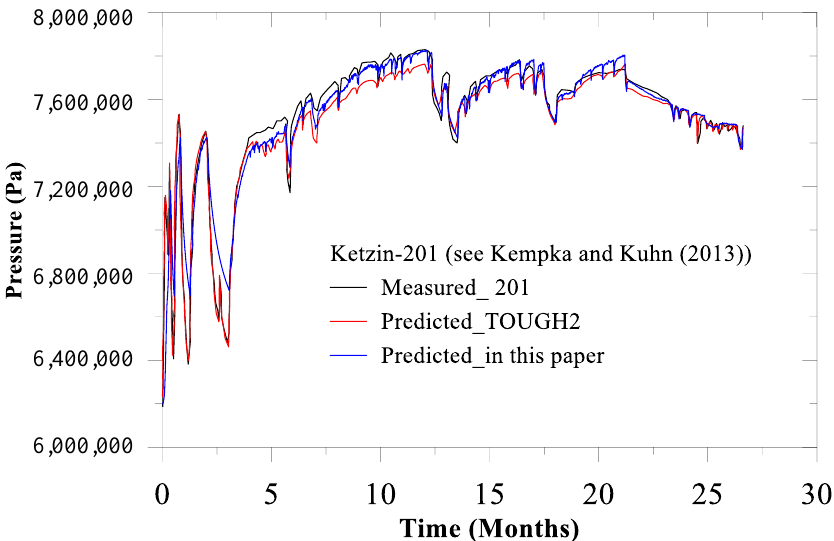
Figure 2. Comparison of measured and predicted pressure response at Ktzin-201 ( Kempka and Kühn [20] , data also available in https://github.com/ufz/ogs5-benchmarks).